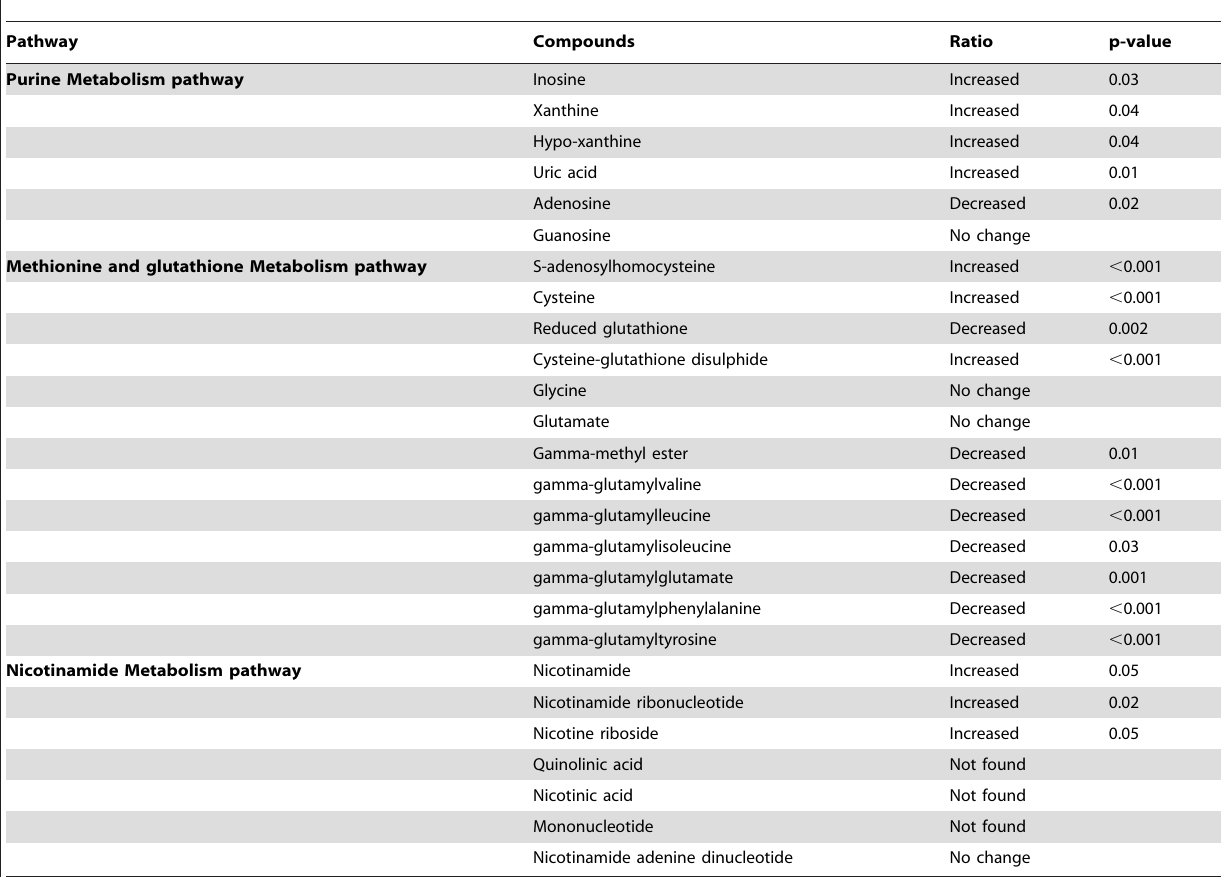
Table 1. Summary of the Biochemical Pathways and Compounds altered in sun-exposed sites.